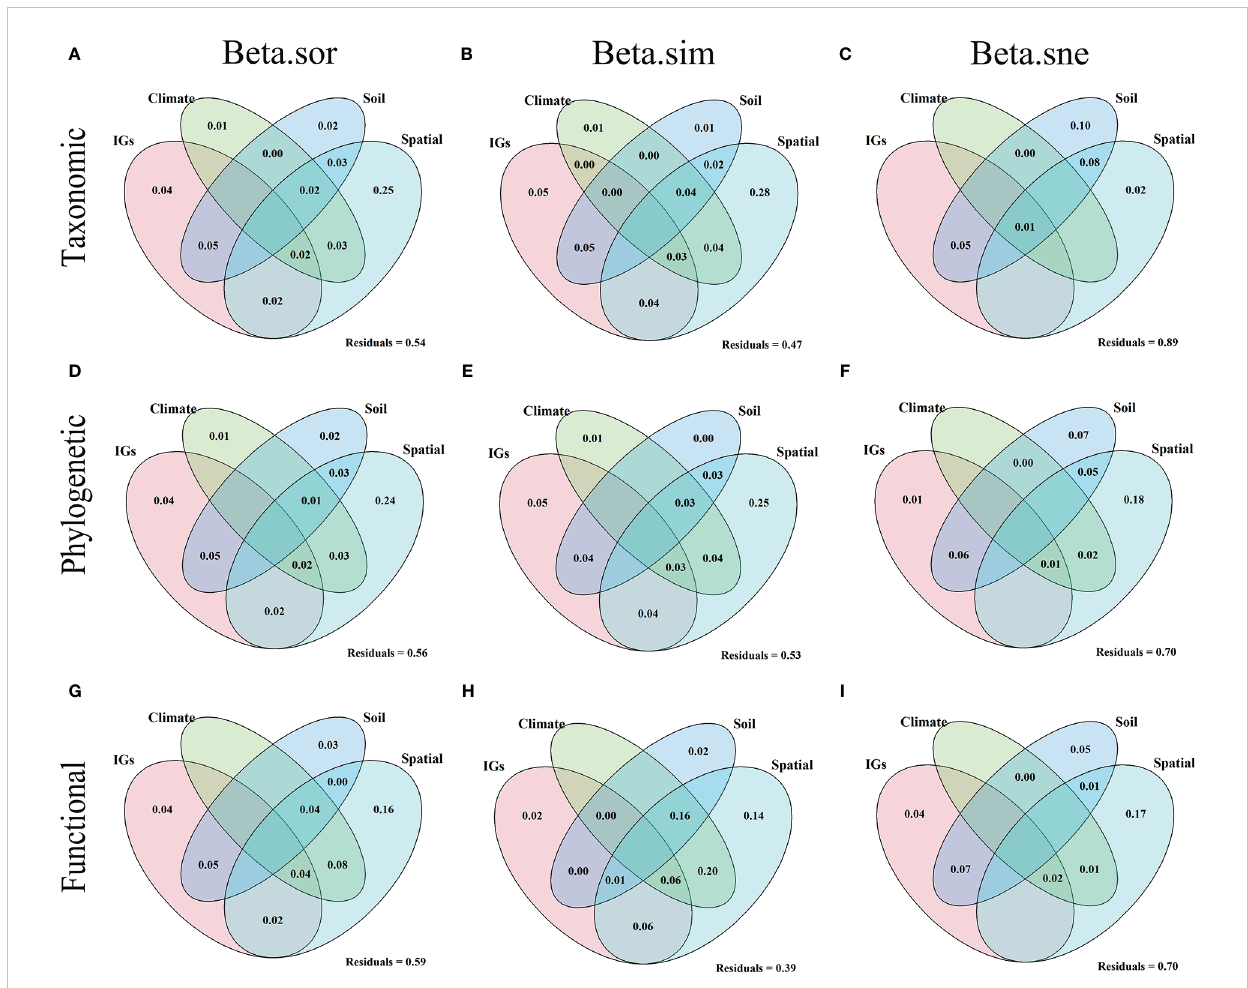
FIGURE 7 Venn diagram based on variance partitioning reveals the variation in taxonomic (A – C) , phylogenetic (D – F) , and functional (G – I) beta diversity explained independently and jointly by inundation gradients (IGs), climate, soil, and spatial factors. The variance (adjusted R2) was explained by inundation gradient (elevation), climate (average annual temperature and precipitation), soil (all soil indicators measured), and spatial factors (all PCMN